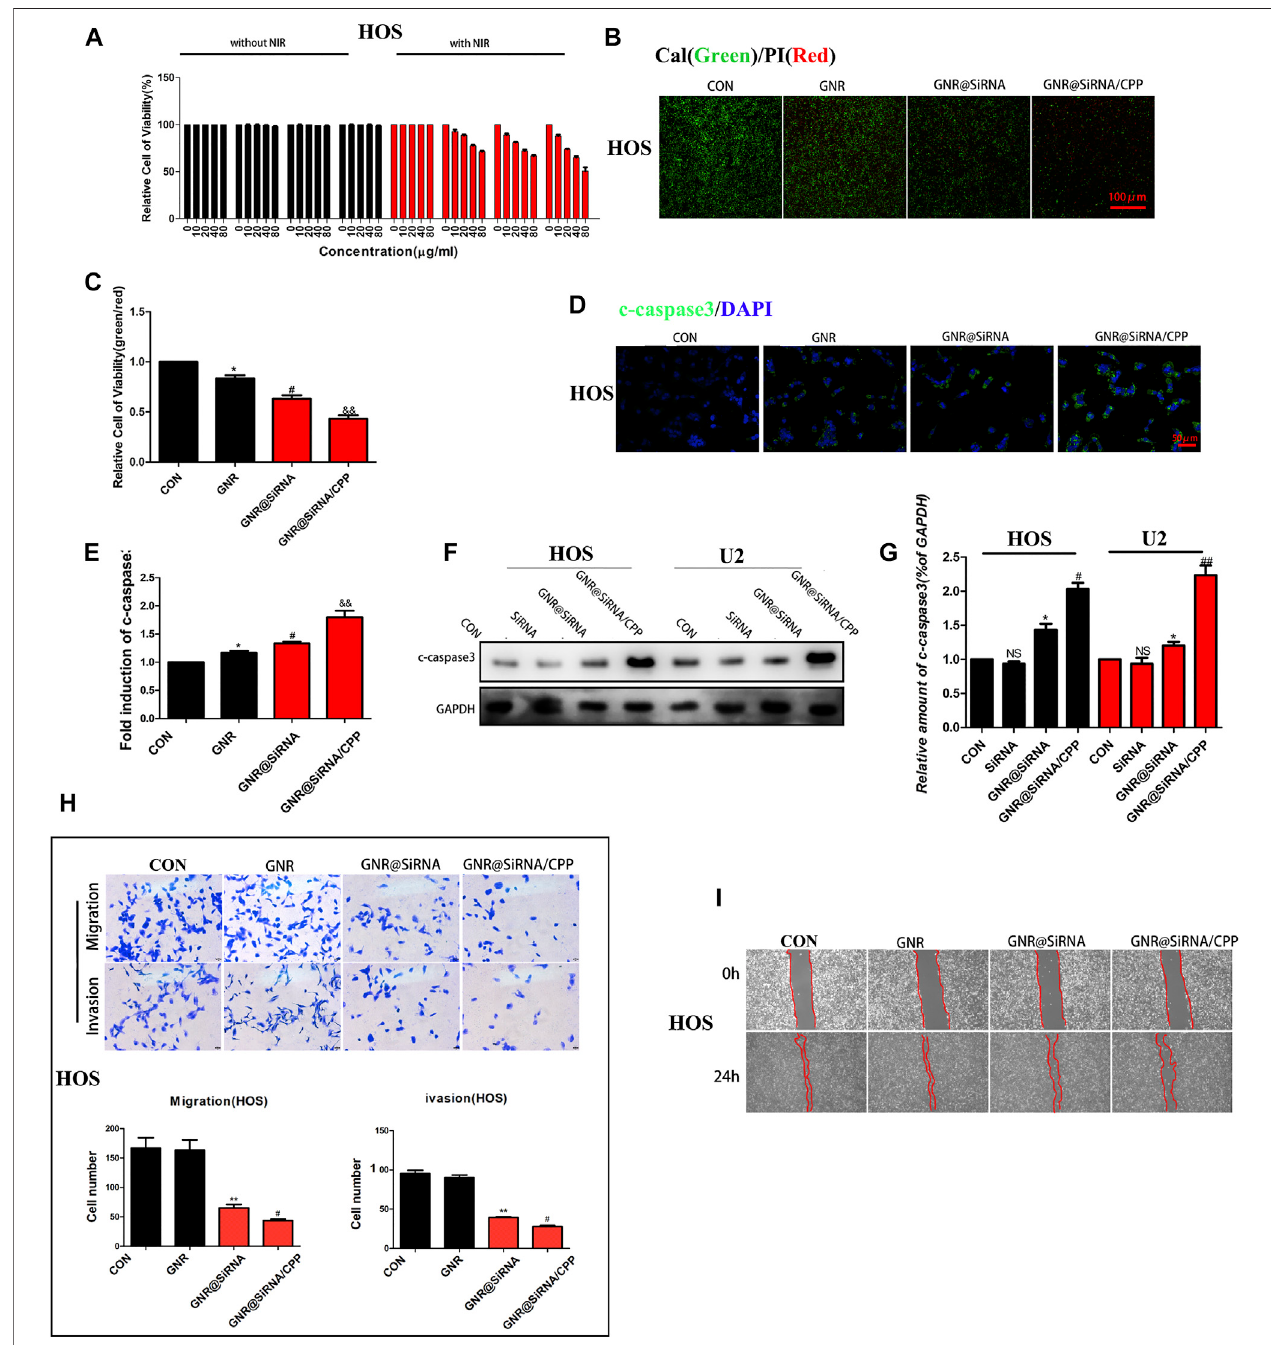
FIGURE 4 | Nanoplatforms inhibit OS cell activity in vitro . (A) Cell-survival rate in OS cells. (B, C) Living/dead staining of OS cells incubated with 100 μ g/ml GNRs and GNR complexes for 24 h and then irradiated under 808 nm NIR laser (1 W/cm 2 ). (D, E) Immuno fl uorescence staining of c-caspase-3 in different groups. (F, G) Western blotting and densitometric quanti fi cation. (H) Migration and invasion assay in different groups. (I) Wound-healing assay in different groups. ( n (cid:2) 5 per group; ** p < 0.01 or *** p < 0.001 vs. CON group; ## p < 0.01 vs. GNR@siRNA group; # p < 0.05 vs. GNR@siRNA group).